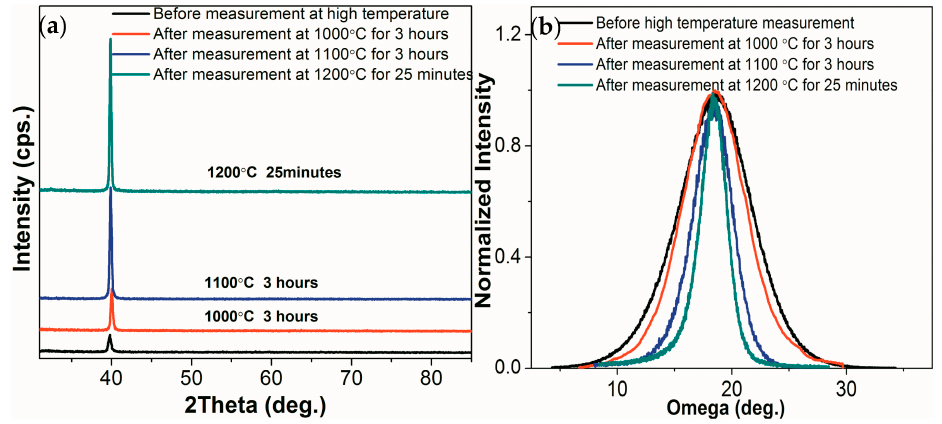
Figure 5. Relative resistance change for the Al 2 O 3 /Pt/ZnO/Al 2 O 3 /LGS and Al 2 O 3 /Pt/ZnO/LGS samples as a function of temperature from room temperature to 1200 °C.